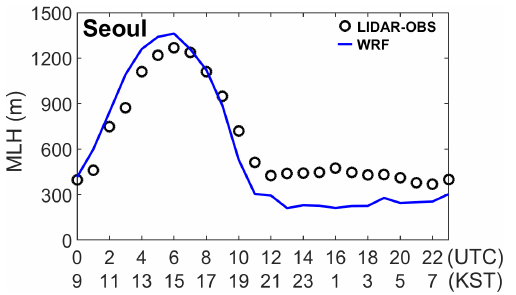
Figure 8. Comparison of WRF-simulated mixing layer height (MLH) (denoted by dashed blue line) with lidar-measured MLH (denoted by open black circles) at Seoul National University (SNU) in Seoul. KST stands for Korean standard